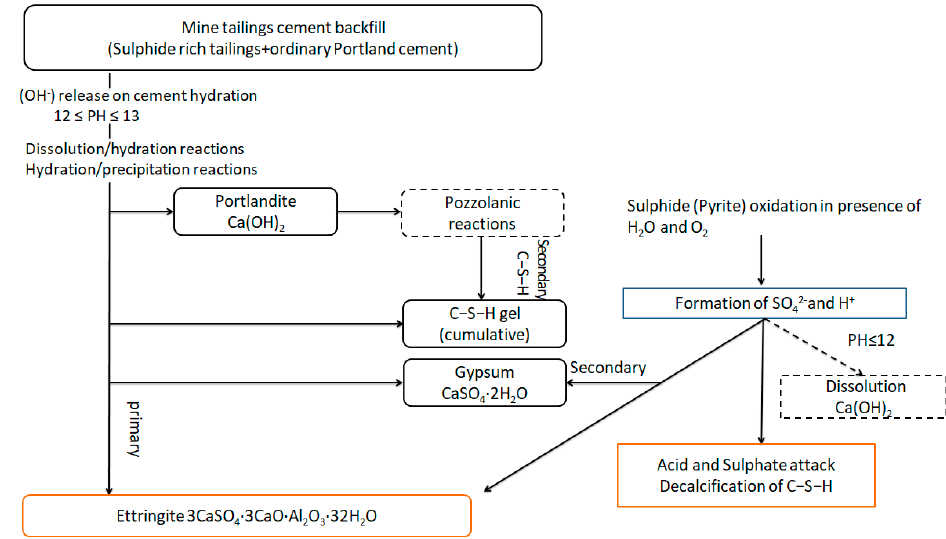
Figure 12. Schematic diagram of the decomposition process in cemented tailings backfill [30].